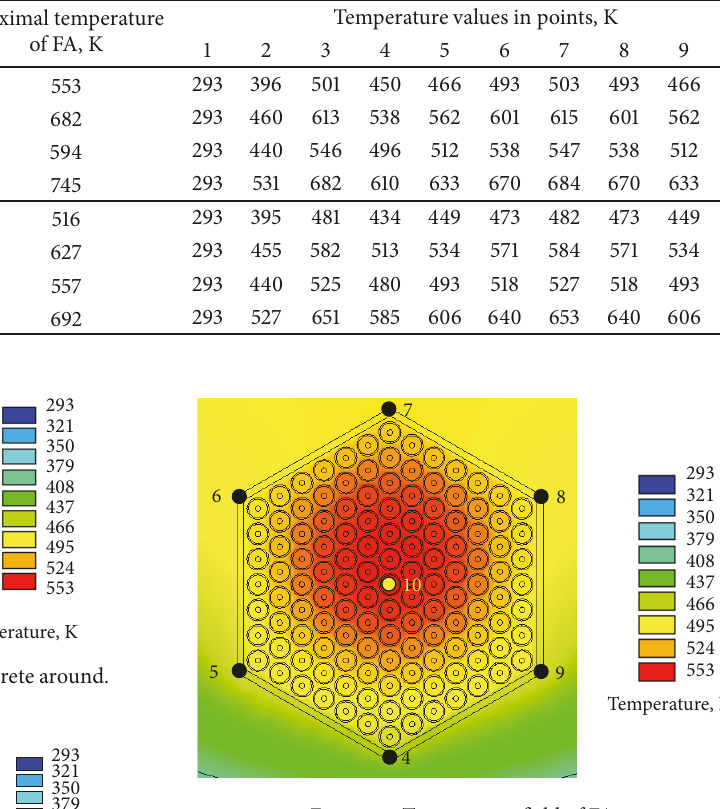
Figure 5: Temperature field of